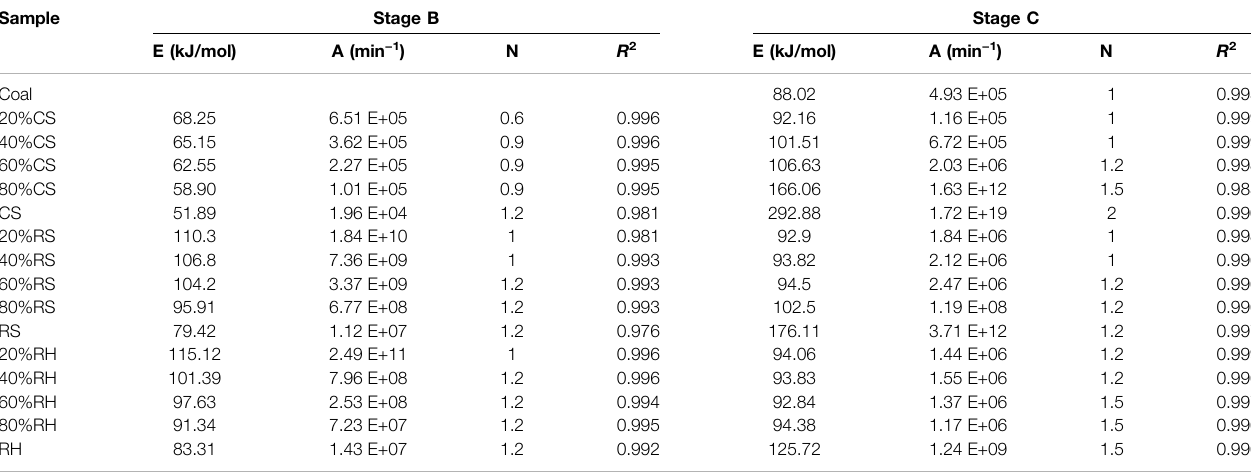
TABLE 4 | Combustion characteristic parameters of the blends.